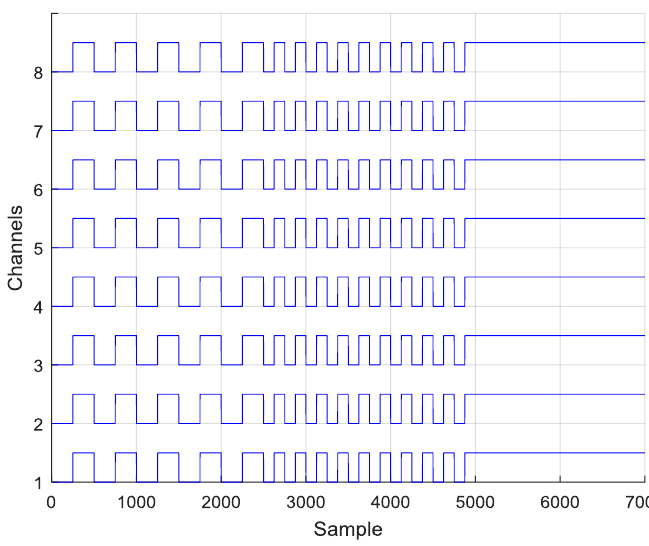
Figure 5. 1 Hz, 2 Hz and DC of recorded internal analog-to-digital converter (ADC) test signals.